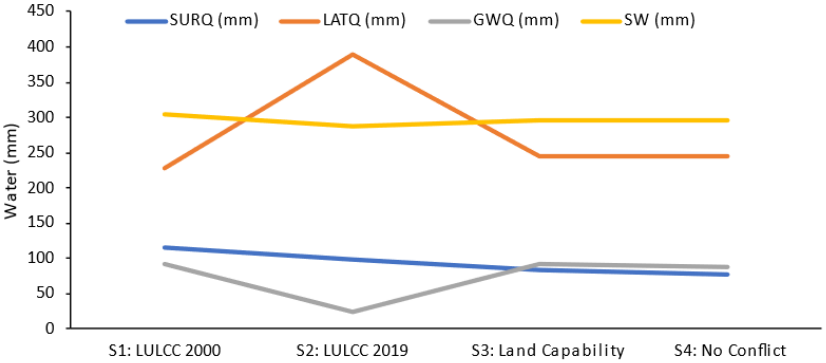
Figure 12. Mean annual changes in runoff (SURQ), lateral runoff (LATQ), groundwater (GWQ), and soil water (SW) using SWAT under different land use change scenarios in the Paraopeba River Basin. When the average annual values of land cover for 2000 and of 2019 are compared (19 years), they show that changes in land use in fl uenced the hydrological behavior of the Paraopeba River Basin (Figure 12 and Table 11). A 70% increase in lateral runo ff (LATQ) and a 74% decrease in shallow aquifer groundwater (GWQ) were observed. Lateral runo ff can expand the scope of the original contamination and enhance the lateral migration of heavy metals into the soil [21]. The tailings deposited in the basin, mainly iron and manganese, spread through the water and negatively contribute to the quality of the river [14]. In this way, minimizing surface runo ff in these regions can help stabilize these contaminants in the rupture area. The forest areas in the landscape reduce the speed of surface runo ff and make it di ffi cult for the tailings to reach the river thalweg [60]. Table 11. Land Use Change from 2000 to 2019. Hydrological Parameters − 2% The scenarios of Land Capability and No Con fl ict may be used to reduce heavy metal contamination along the watershed. As we can see in Figure 12, these scenarios make it possible to reduce lateral runo ff (LAT) and increase water in fi ltration into the soil (GWQ). Simply returning to the land capability uses in the regions of con fl ict of use, the basin returns to the lateral fl ow and groundwater levels of 19 years ago. Table 12 summarizes the average annual coverage values for 2019, comparing the annual average values and the percentage change with both scenarios. The absence of land use con fl ict is capable of reducing the SURQ by 20% and the LATQ by 37%, achieving a 265% increase in the water table (GWQ).